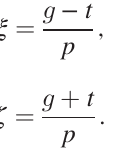
FIG. 4. Corrugation variation with the spacing parameter ξ and sidewall parameter ζ for the minimum radii (top), maximum radii (middle), and unequal radii (bottom) profiles at fixed period and